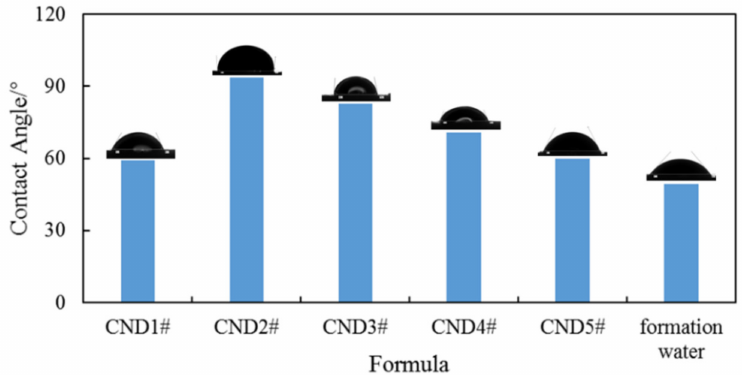
Figure 10. Contact angles of rock cores after soaked in